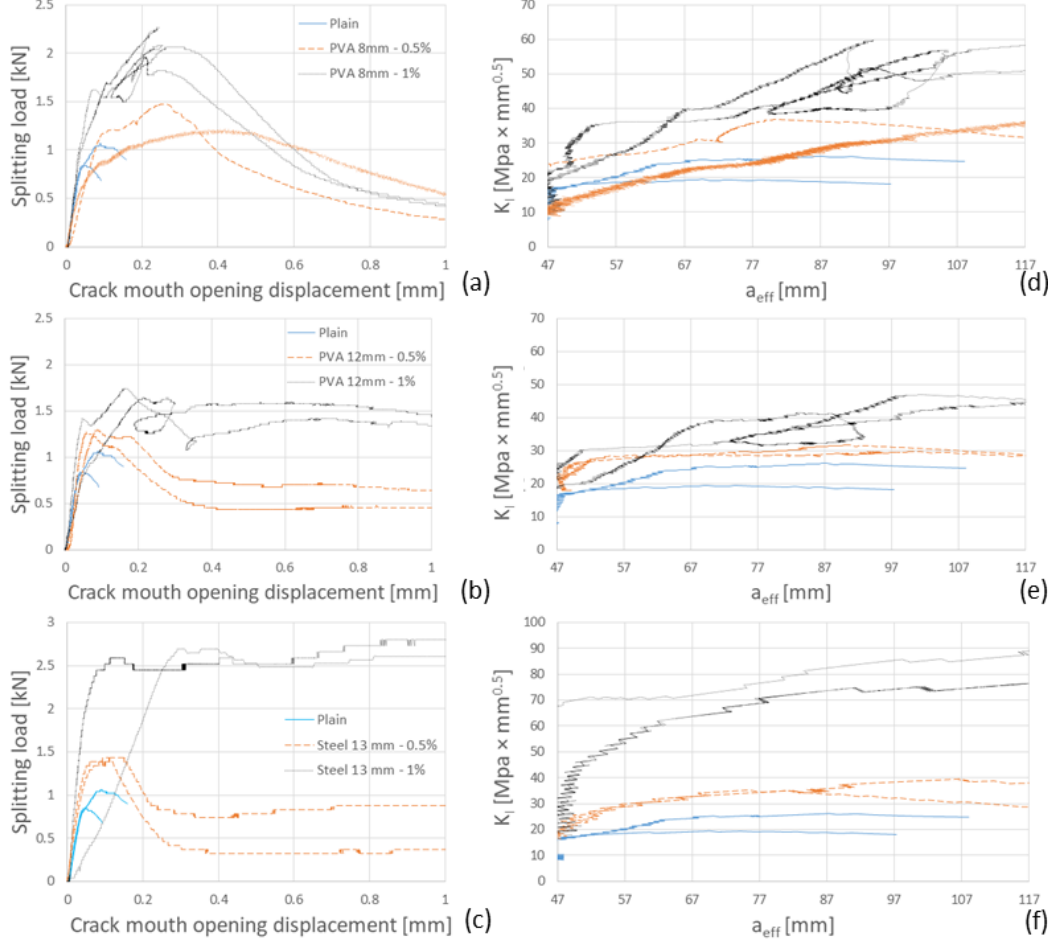
Figure A1. Splitting load (SL) versus crack mouth opening displacement (CMOD) curves of ( a ) 8 mm PVA FRC; ( b ) 12 mm PVA FRC; ( c ) 13 mm Steel FRC, crack growth resistance curves (in terms of SIFs, KI, versus effective crack length, aeff) of ( d ) 8 mm PVA FRC; ( e ) 12 mm PVA FRC; ( f ) 13 mm steel FRC .